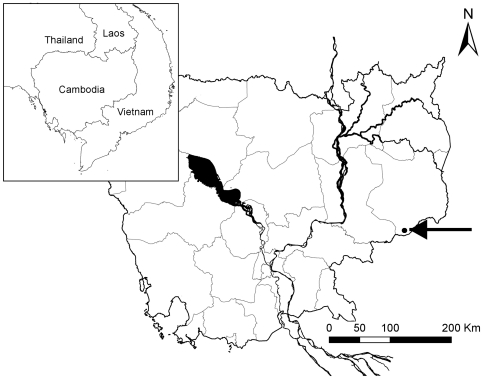
Location of Seima Protection Forest, Cambodia.The study site is indicated on the map.